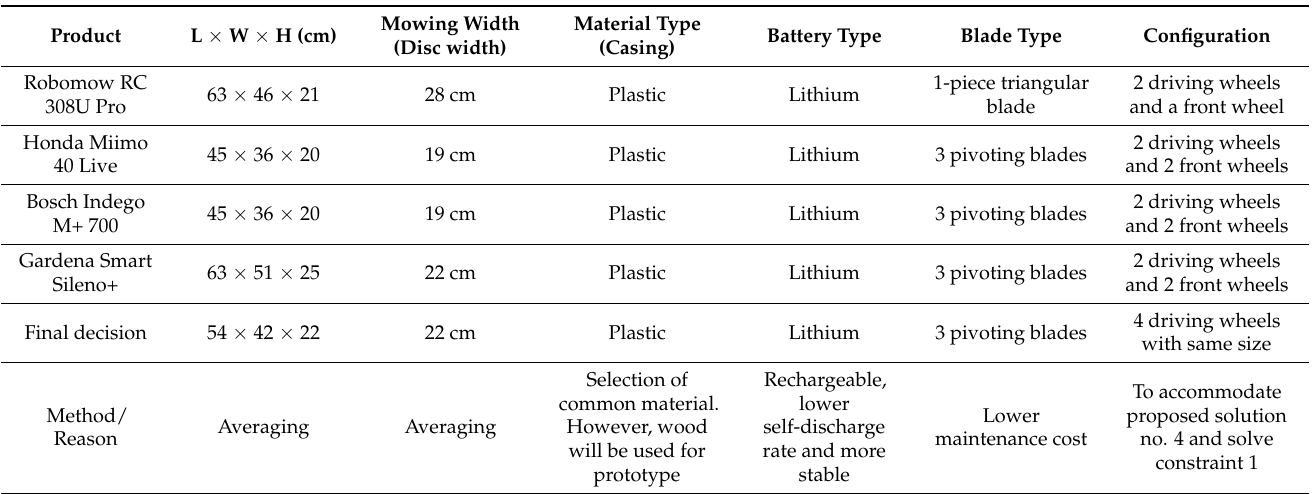
Table 18. Base model